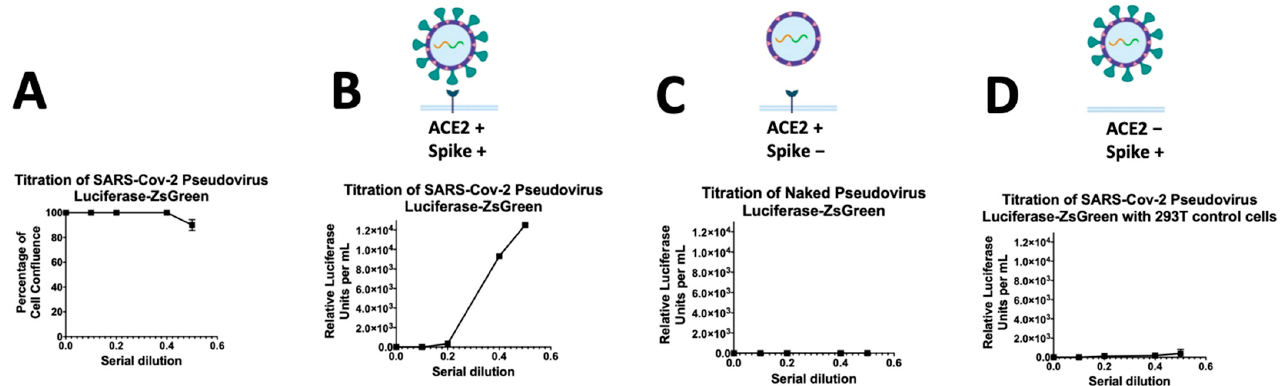
Figure 2. Titration of SARS-CoV-2 spike-pseudovirus particles in 293T cells expressing ACE-2. ( A